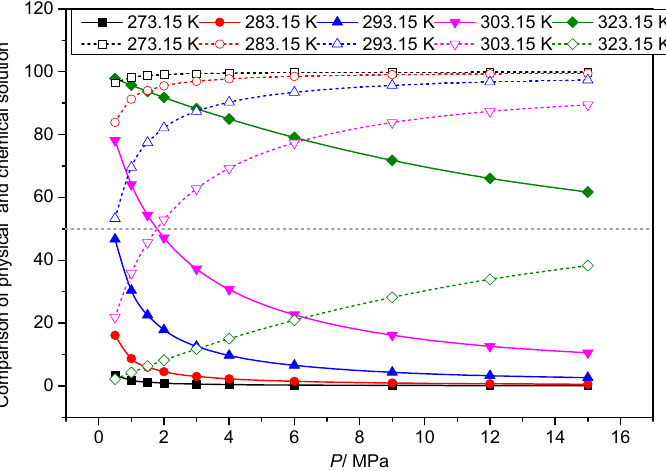
Figure 12. Variation curves of physical and chemical solubility ratios with pressures.